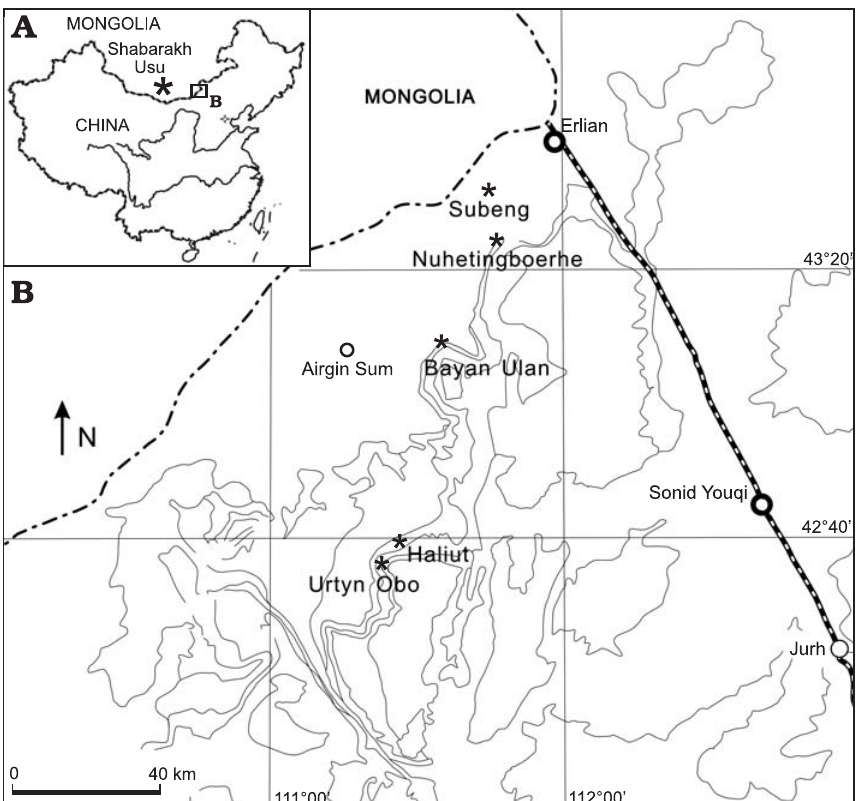
Fig. 1. Late Paleocene Gashatan localities for multi tuberculates in the Mongolian